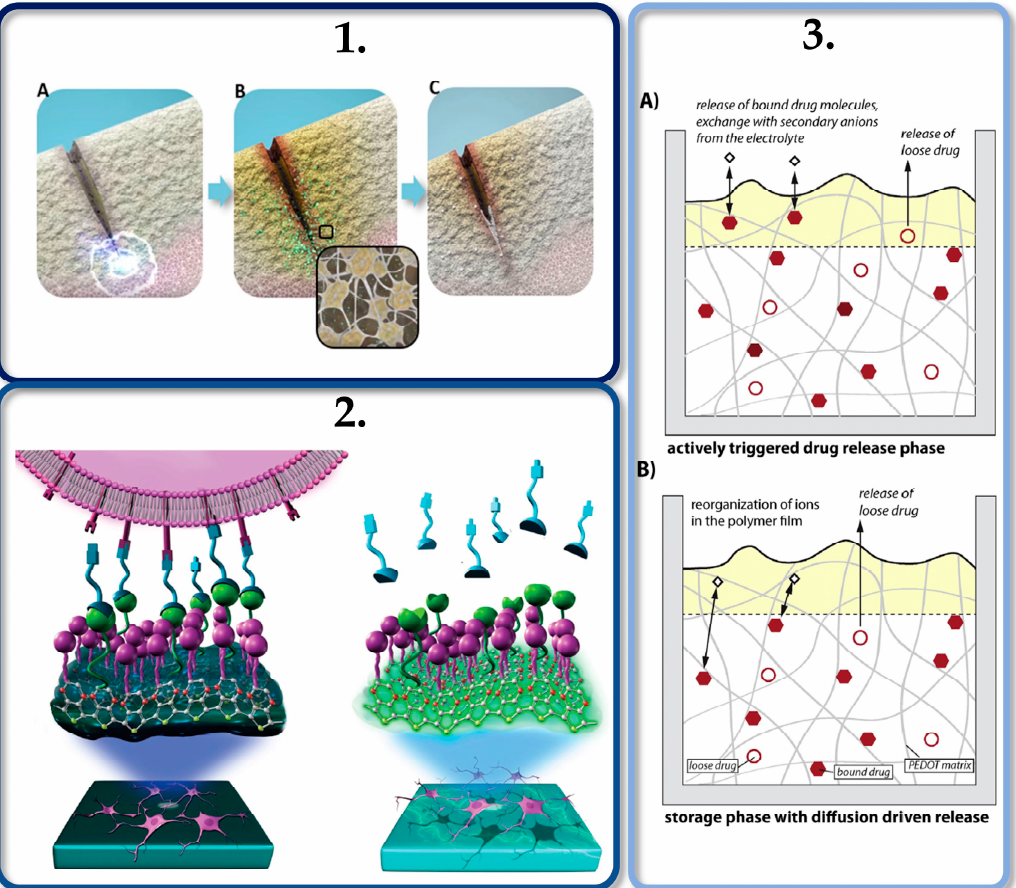
Figure 4. ( 1 ) Flexoelectricity induced by mechanical stimulation ( A ) plays an important role in bone repair and remodeling by inducing osteoblasts migration ( B ) and mineralization ( C ). Reproduced from [109] under Creative Commons Attribution License. ( 2 ) Electrical communication and redox-triggered interaction between neurons and (PEDOT) matrices functionalized with hydroquinone electroswitches and phosphorylcholine zwitterions. ( 3 ) Schematic representation of the active drug-delivery triggered by an electrical stimulus ( A ) and passive drug-release induced by diffusion processes from a conductive polymeric matrix ( B ). Reproduced from [158] and [151] under Elsevier Copyright Clearance Center (CCC) licenses.